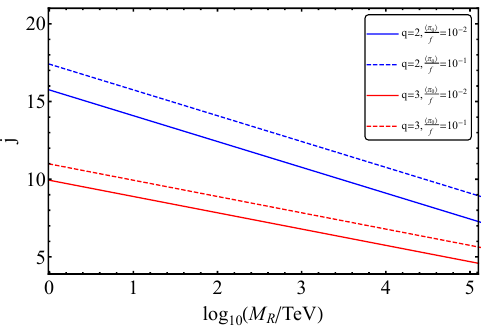
Figure 2 . The (cid:12)gure shows variation of the site number at which the right handed neutrino should couple to the one-sided clcokwork setup as a function of its Majorana mass. We present in the solid lines the variation assuming h (cid:25) 0 i =f (cid:24) 10 (cid:0) 2 and in dashed lines assuming when h (cid:25) 0 i =f (cid:24) 10 (cid:0) 1 for both q = 2 (blue) and q = 3